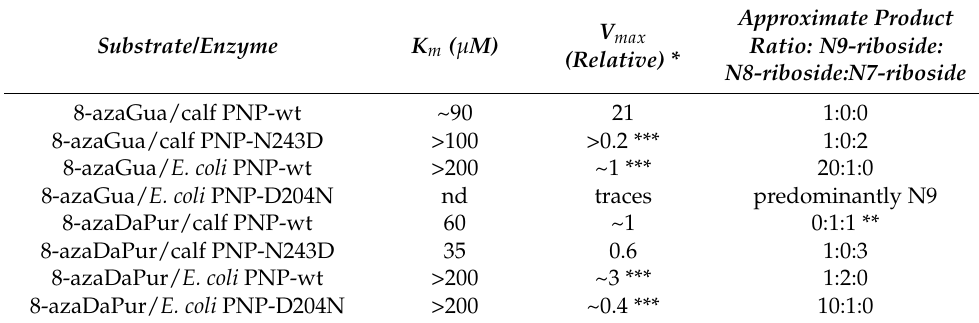
Table 1. Kinetic parameters for enzymatic ribosylation of selected 8-azapurines in 25 mM HEPES buffer, pH 6.6, by α - D -ribose-1-phosphate, using various forms of PNP (nd = not determined). Standard errors are estimated to be ~15%.